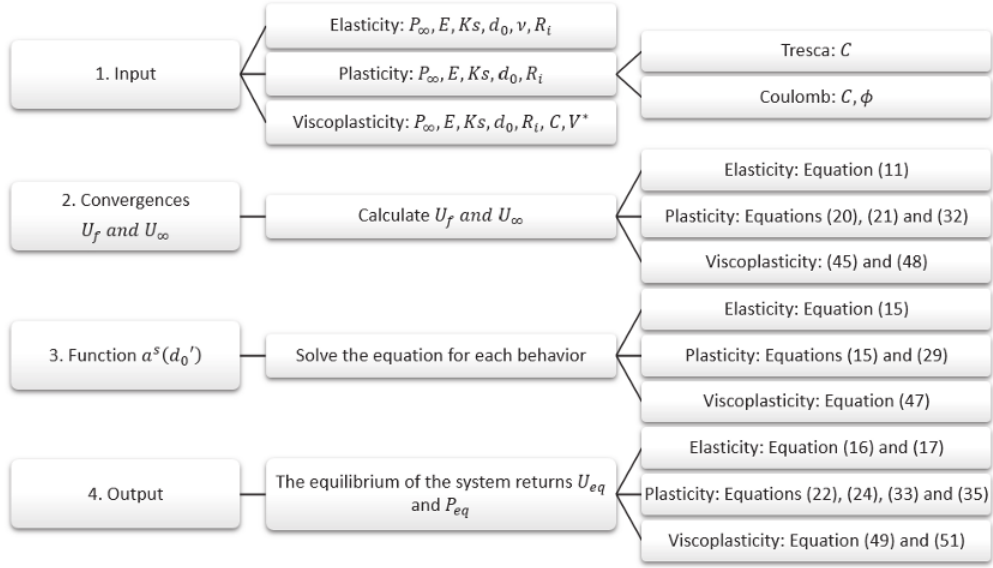
Sequence of solution of a tunnel convergence U